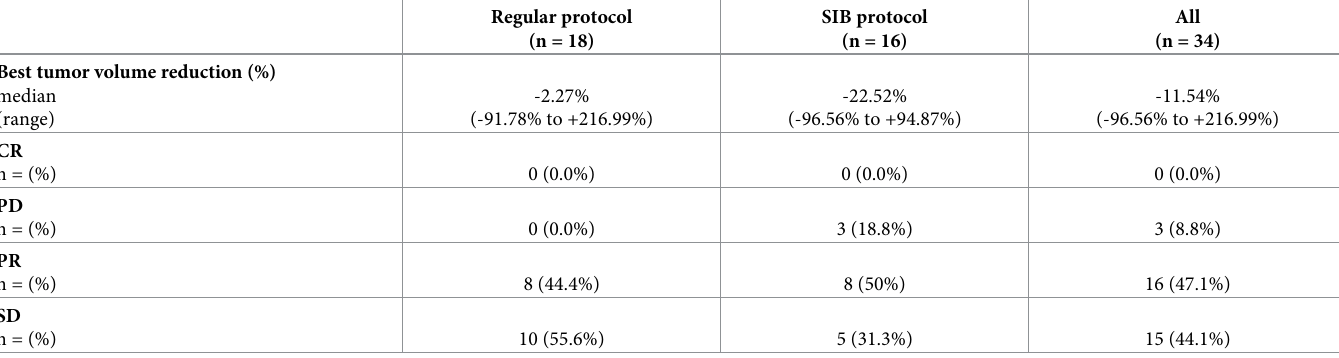
Table 3. Best tumor volume reduction and